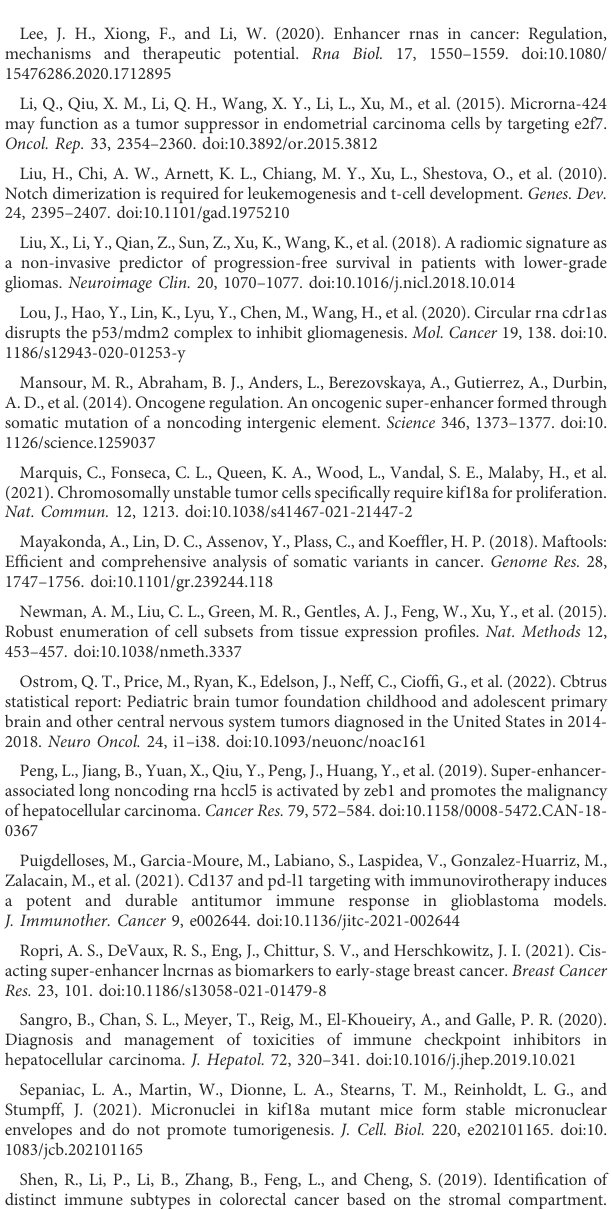
scores and tumor purity, TIDE, T-cell exclusion score, MSI score and T-cell dysfunction score between high and low-risk groups in TCGA cohort. * P < 0.05, ** P < 0.01, and *** P <